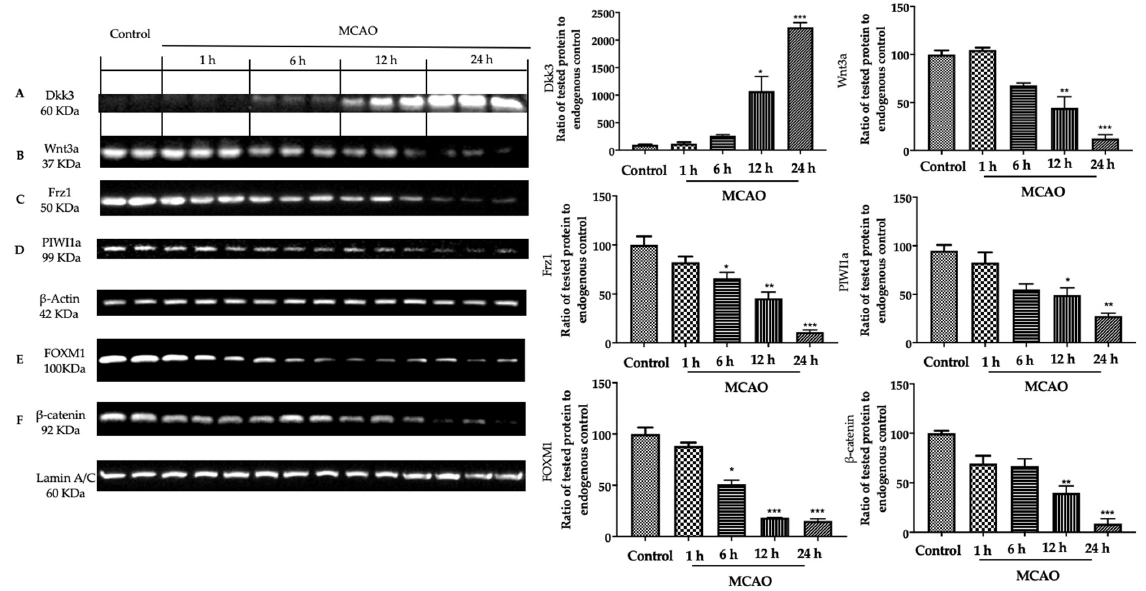
Figure 3. Analysis of Dkk3 levels in ischemic brain: Western blot analysis of ( A ) Dkk3, ( B ) Wnt3a, ( C ) Frz1, ( D ) PIWI1a, ( E ) FOXM1, ( F ) β‐ catenin. For these analyses, n = 5 animals for each group